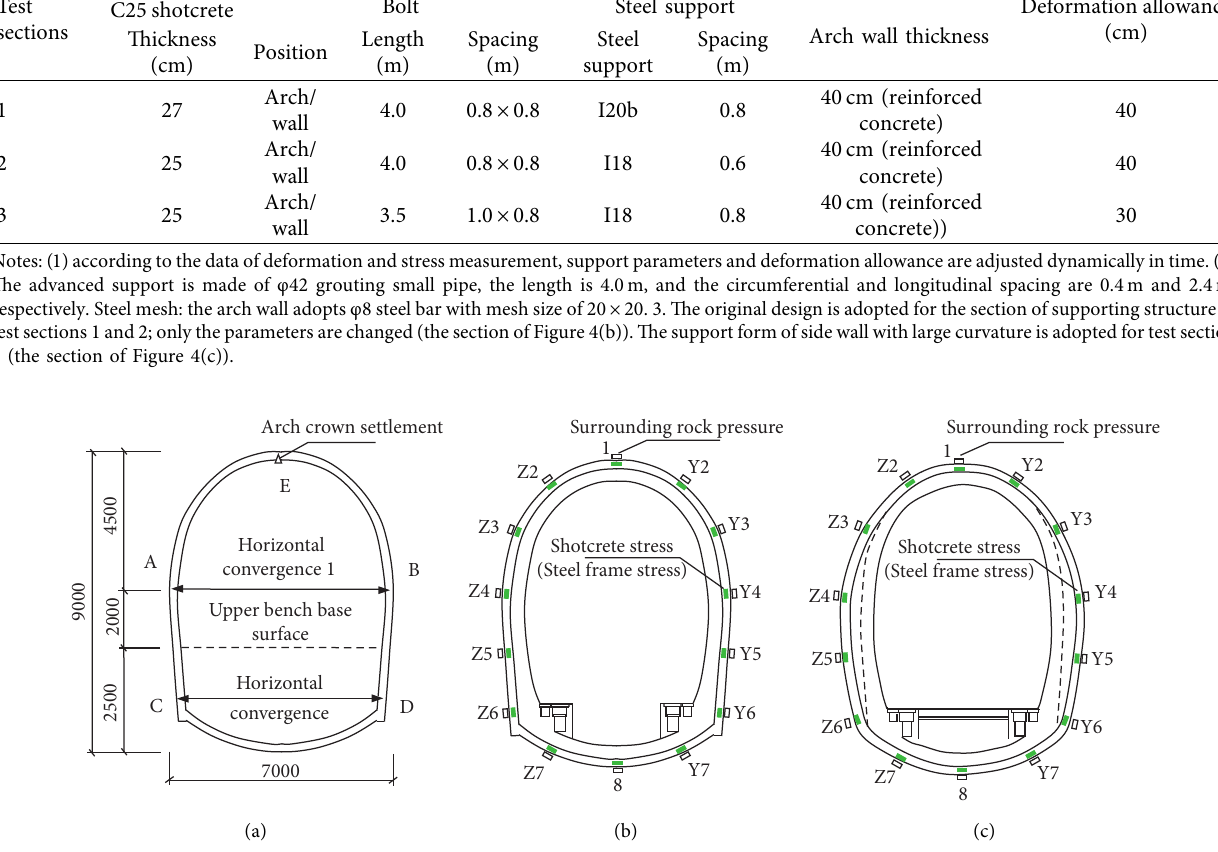
Figure 4: Location for measuring points in support system. (a) Displacement measuring points. (b) Section A. (c) Section C.